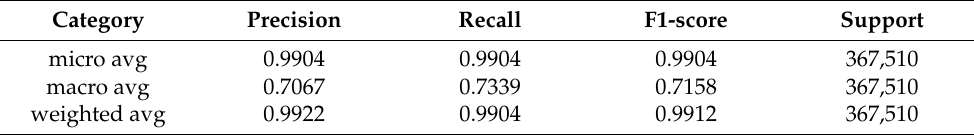
Table 9. Results of EfficientNet B7 with 8000 images per class.